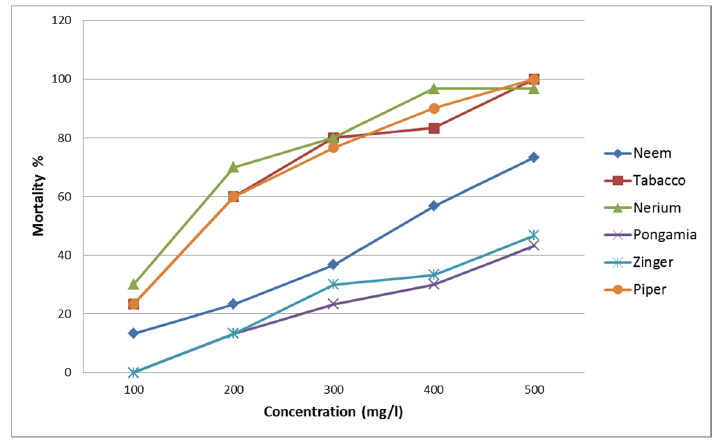
Figure 1. Molluscicidal activity of six plant extracts at different concentrations on P. maculata .